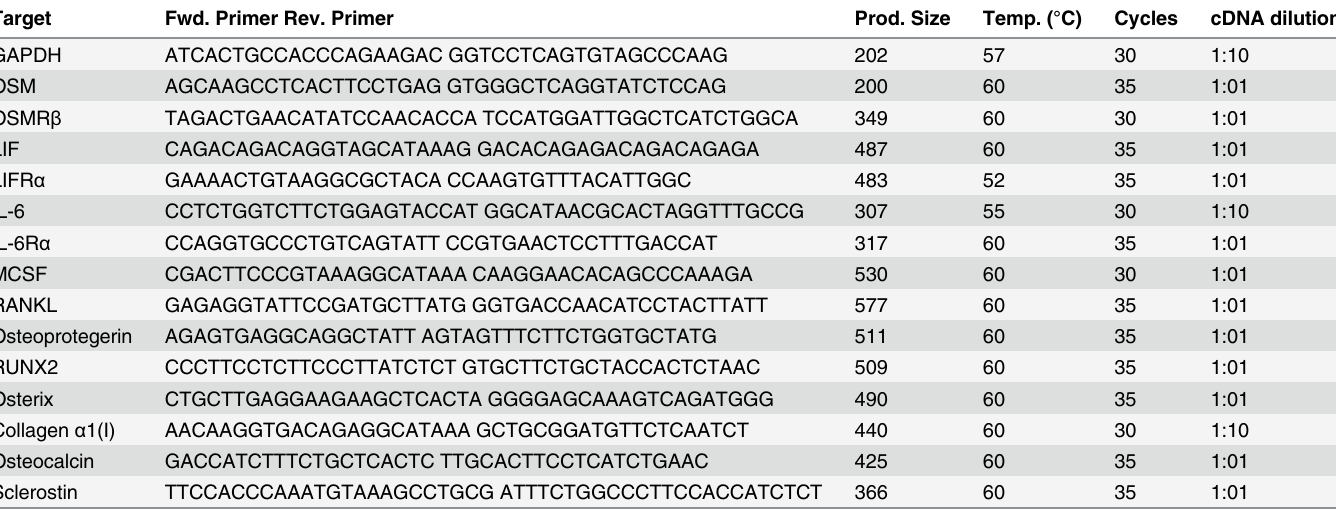
Table 1. PCR Primers and Reaction